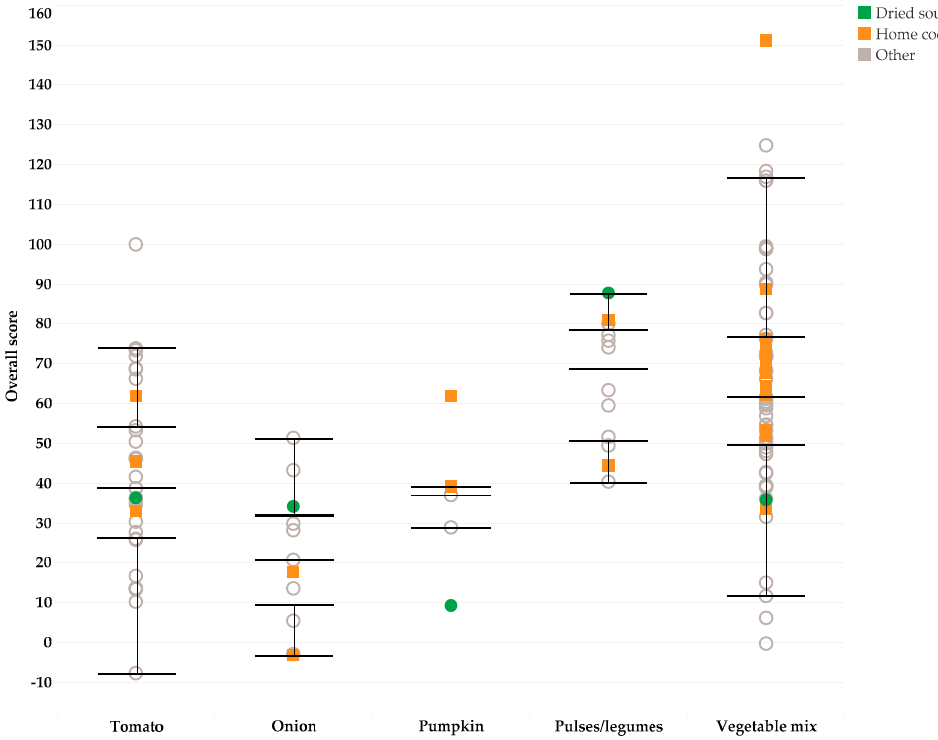
Figure 1. Nutrient density scores of dry vegetable soups with home-made and other soups.